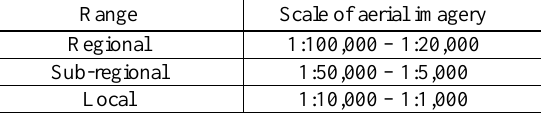
Table 2. Classification of aerial imagery as DTM source data